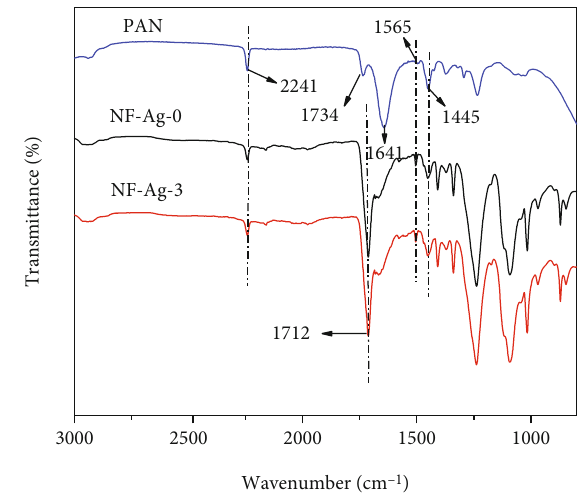
Figure 6: FTIR-ATR spectra of typical 2